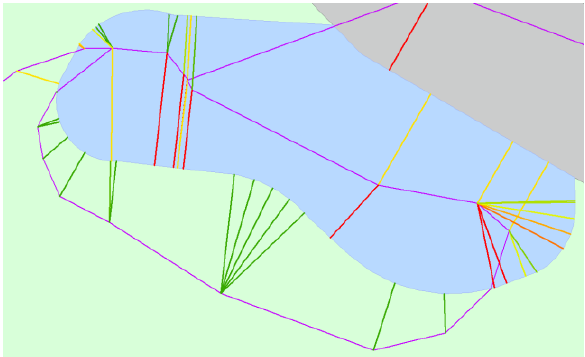
Figure 12. ALKIS (black) and ATKIS (purple) data overlay for pond area. Links with similarity indication (coloured lines) In this case the algorithm chose the links based on the orientation of the polygon, as the matching land-use classes around the bank of the pond have to appear in the same orientation for both line segments. This leads to a nice alignment of both datasets.